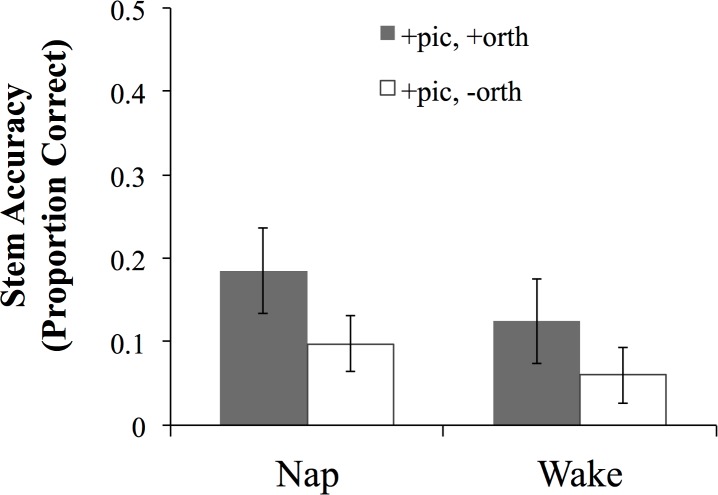
Proportion of correctly recalled stems in the cued recall task in the two groups for the conditions with and without the additional orthographic cue.Error bars represent 95% CIs.